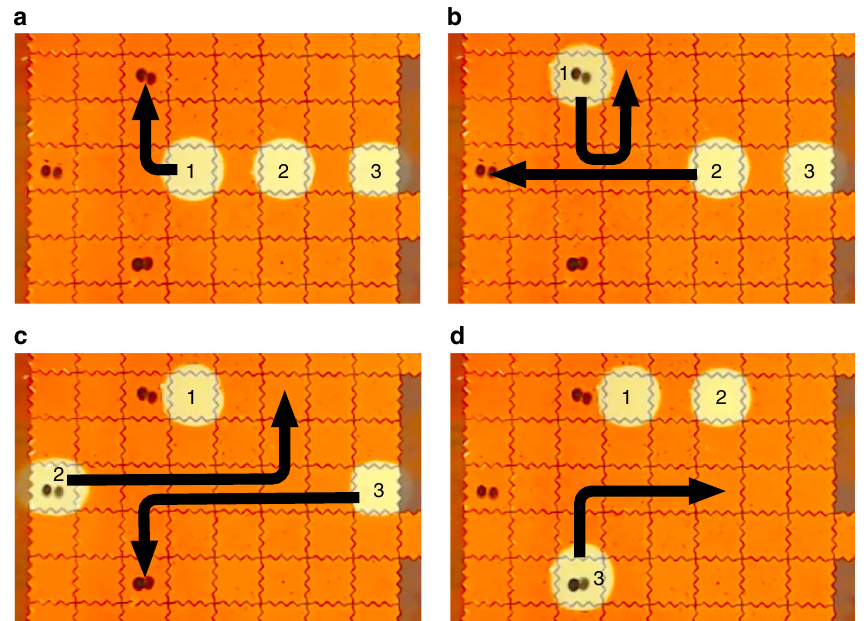
Fig. 5 DMF setup for path contamination tests. a Three different fi les are spotted at different locations on the cartridge. Three retrieval droplets are initiated on the DMF device. Droplet 1 is moved to the north-most fi le. b Droplet 1 moves to its fi nal coordinate. Droplet 2 then moves to the west-most fi le, passing two electrodes Droplet 1 had moved across. c Droplet 2 moves to its fi nal coordinate. Droplet 3 moves to the south-most fi le, using a part of the path both droplets 1 and 2 had used. d Droplet 3 moves to its fi nal coordinate for manual retrieval and analysis